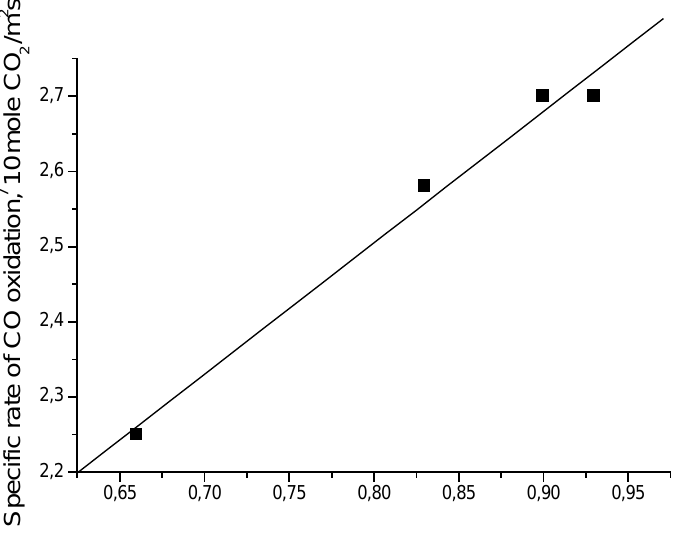
Fig.4 Dependence of the specific rate CO oxidation vs. the concentration of stacking fault measured by X-ray diffraction.